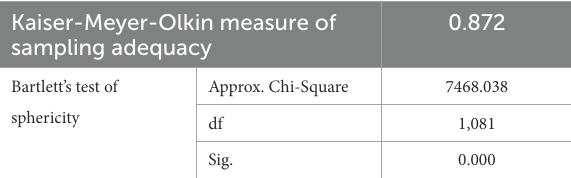
TABLE 1 Kaiser–Meyer–Olkin (KMO) and Bartlett’s tests for sample adequacy of HCWCIOS. Kaiser-Meyer-Olkin measure of sampling